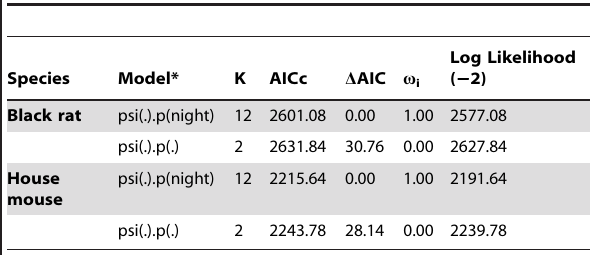
Table 2. AICc model selection for the detection probabilities for two species with the potential to impact on the conservation values of the Summerland Peninsula.